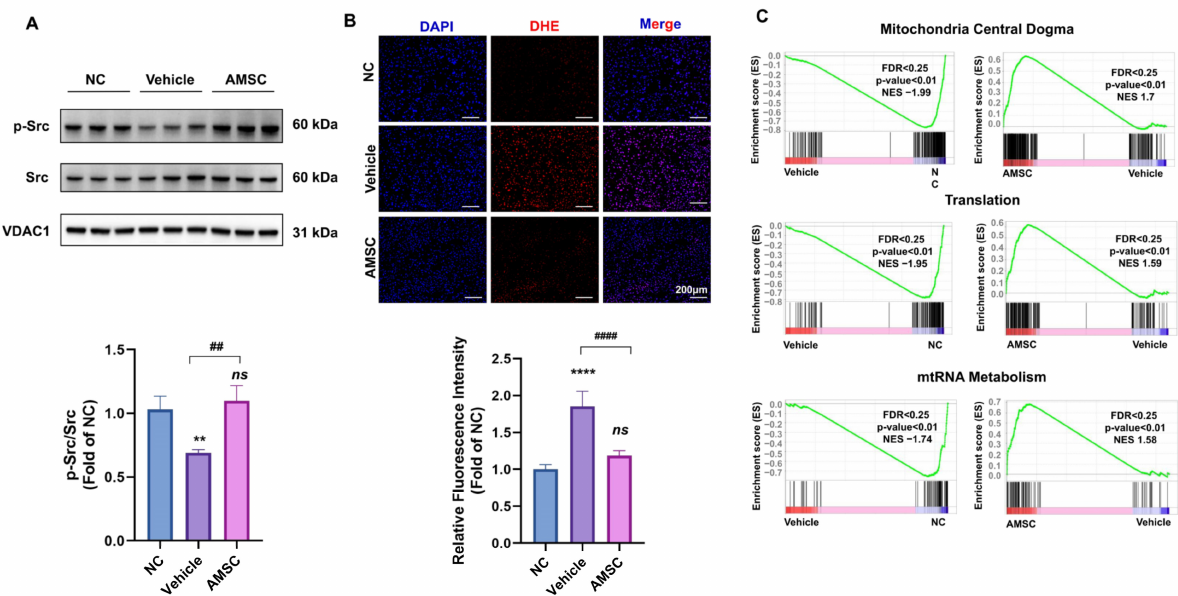
Figure 6. AMSCs inhibit ROS production and restore mitochondrial function. ( A ) Western blot analysis of p-Src and Src levels in isolated mitochondria from mouse liver tissues after treating with APAP and AMSCs for 6 h. ( B ) The measurement of ROS content in liver tissue by DHE staining and quantification by measuring the mean gray value of DHE. ( C ) GSEA plots of significantly different mitochondrial pathway gene sets in the vehicle group versus the NC group and the AMSC group versus the vehicle group. Data are presented as the mean ± SD; n = 3–5; ** p < 0.01, **** p < 0.0001 and ns: no significance vs. NC group; ## p < 0.01 and #### p < 0.0001 vs. APAP group. NC group: normal control mice; vehicle group: APAP-overdosed mice; AMSC group: AMSC-treated